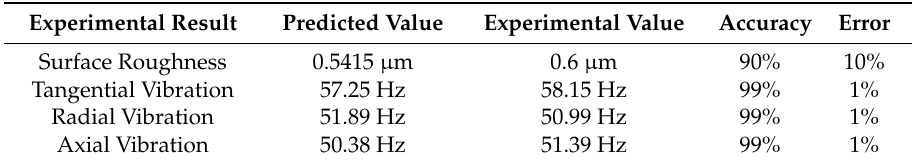
Table 8. Comparison of experimental and predicted